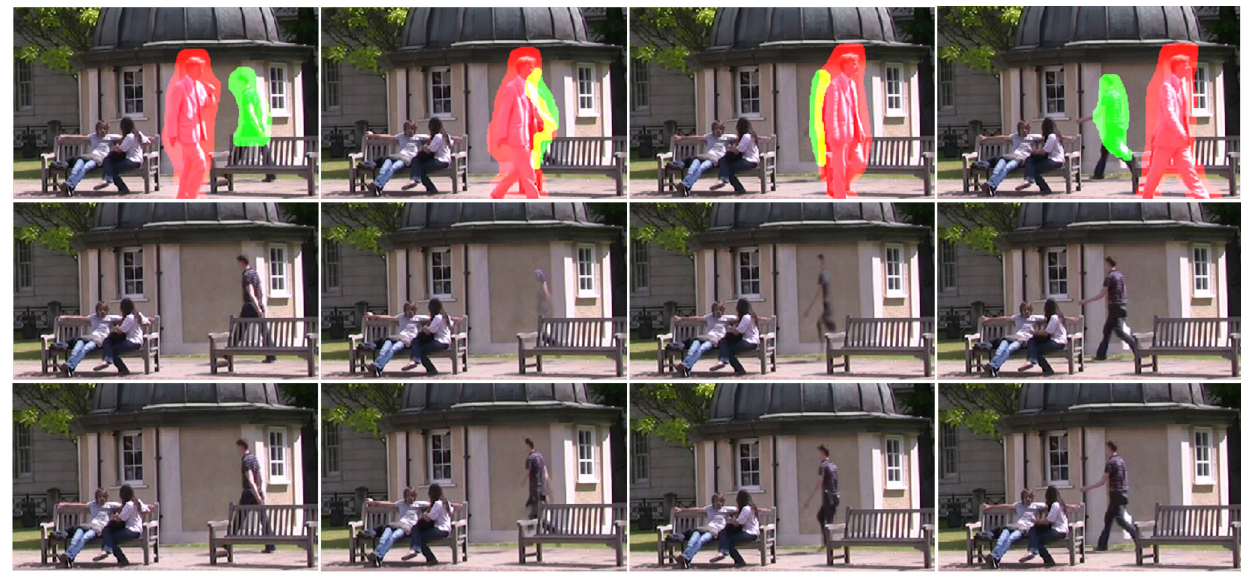
Fig. 12 Qualitative comparison with Newson et al.’s method [59]. Top: our segmentation masks; red and green masks denote different objects, and yellow shows the overlap region between two objects. Middle: results from Ref. [59] performed on our segmentation masks. Bottom: our inpainting results performed on the same